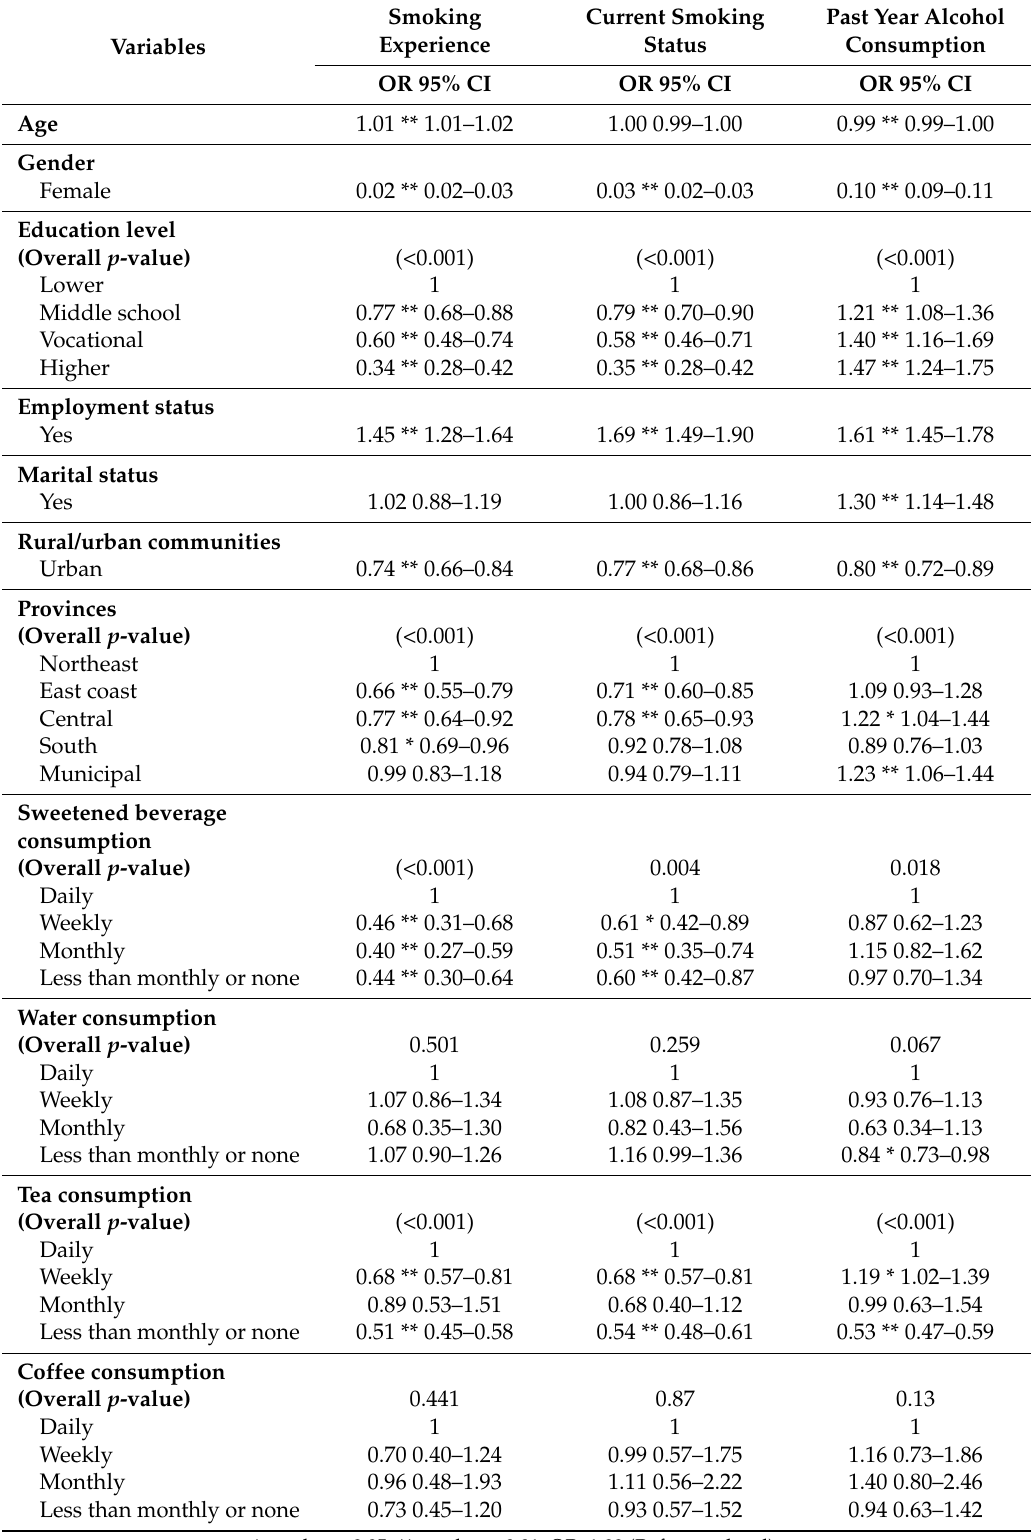
Table 2. Odds ratios (OR) and 95 percent confidence intervals (95% CI): Associations among beverage intake frequencies, smoking, and alcohol consumption behaviors are adjusted for all covariates. Data source: China Health and Nutrition Survey,